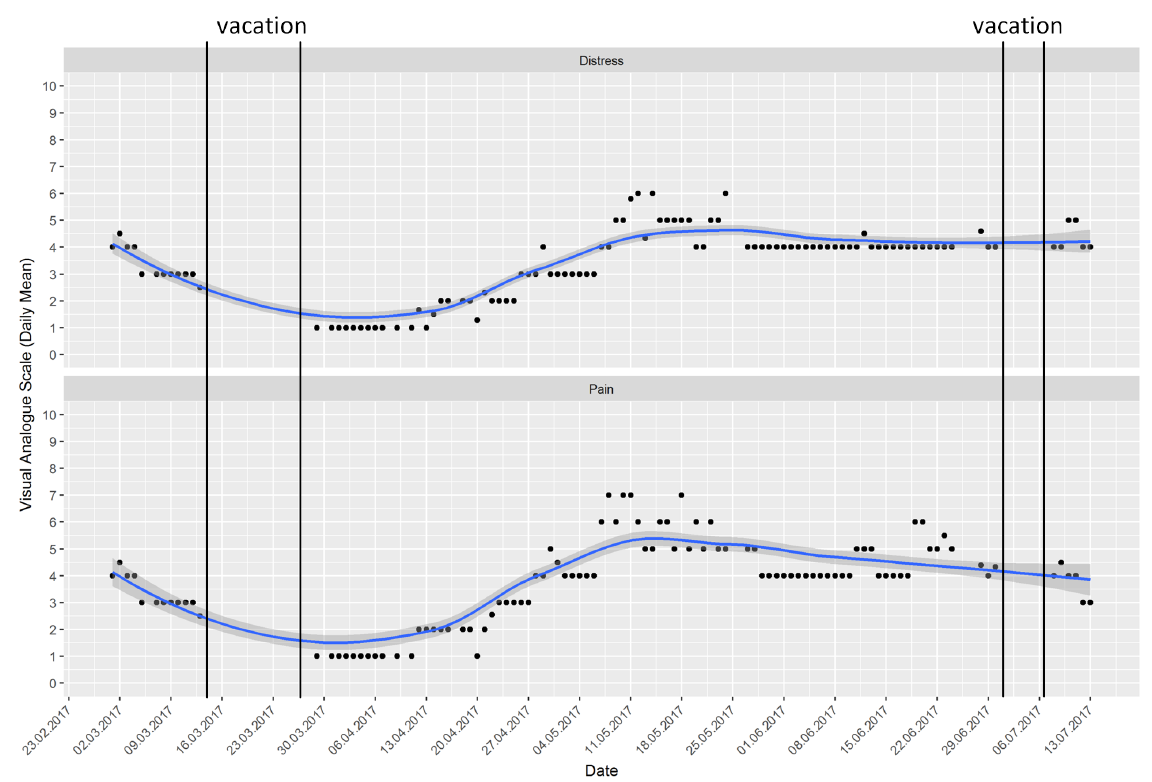
Figure 3. Self-rated pain and distress of one patient with values from 0 (no symptom) to 10 (max. severity of symptom). Symptoms were reduced after vacation and increased during daily